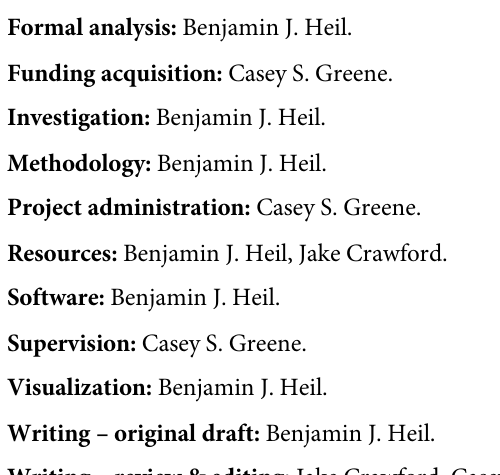
S4 Fig. Performance of Recount3 multiclass prediction with pretraining.